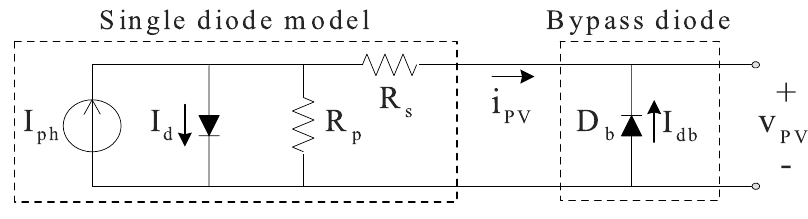
Figure 4. Single-diode model of a PVM including a bypass diode.